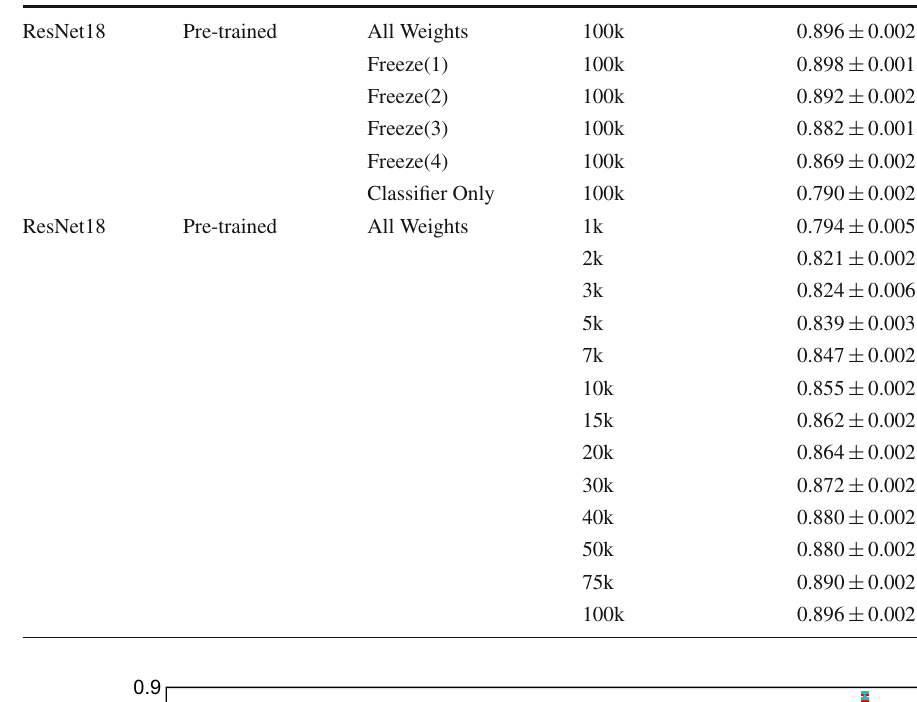
Fig. 3 The test sample (cyan) and validation sample (red) F1 scores as a function of the number of images used to train the all-weights transfer learning networks. The three grey bands provide a visual guide to compare the performance to: Kaiming-initialised networks when trained with 100,000 (top) and 50,000 (middle) images, and transfer learning using 100,000 images in the classifier-only case